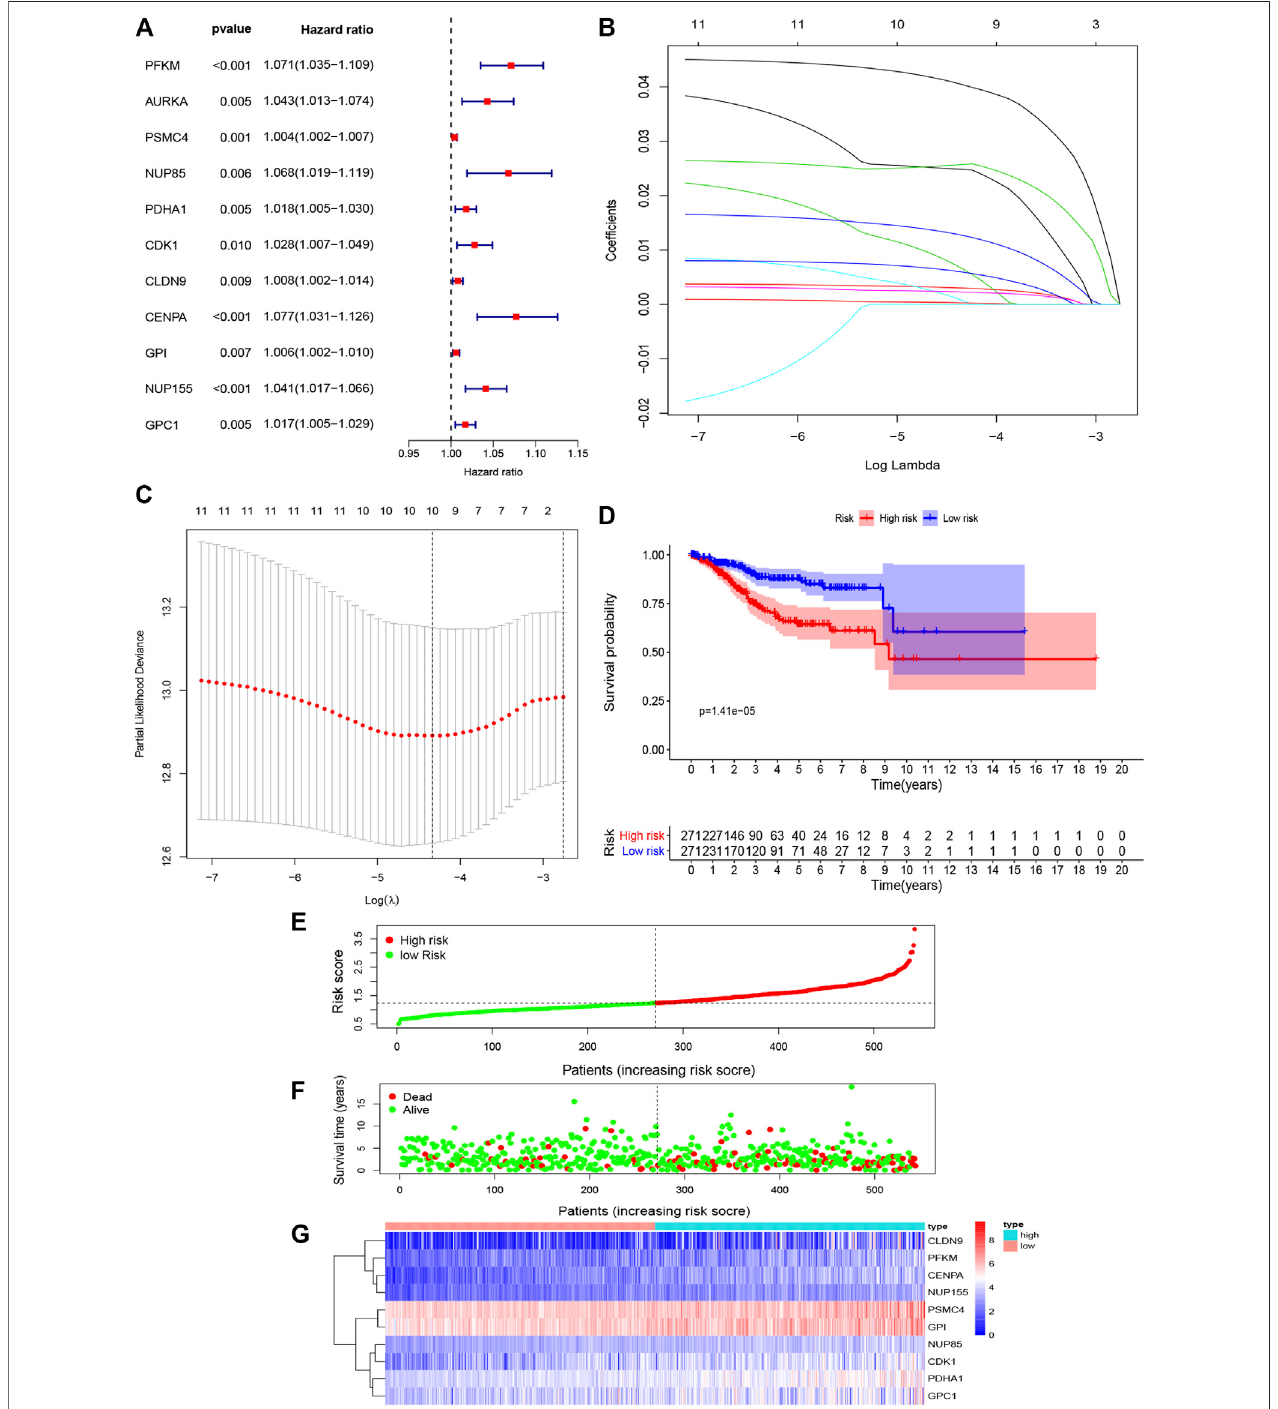
FIGURE 4 | Construction and validation of prognostic model prognosis-associated genes of EC (A) . Results of univariate Cox analysis for the prognostic genes in EC. (B,C) . LASSO regression model (D) .Kaplan-Meier analysis forthe 10glycolysis-related genesignatures related torisk scorepredicts overallsurvival inpatientswith EC (E) . Gene signature-related risk score distribution in each patient (F) . Survival days of patients in order of the value of risk scores (G) . A heatmap of 10 glycolysis- related gene signatures.